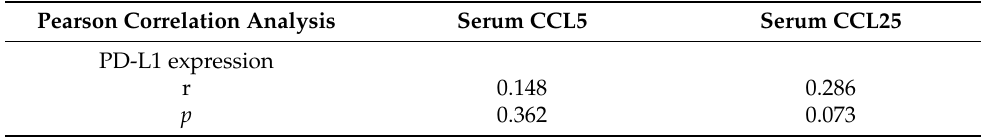
Table 5. Relationship between serum CCL5/CCL25 and PD-L1